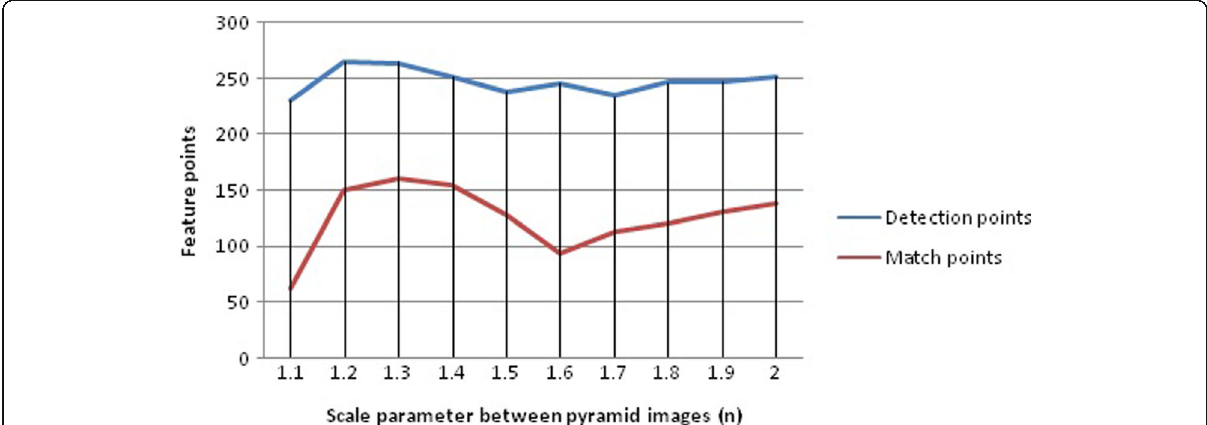
Fig. 28 Comparison of the number of feature points detected and the exact number of matches between the scale parameters of the pyramid